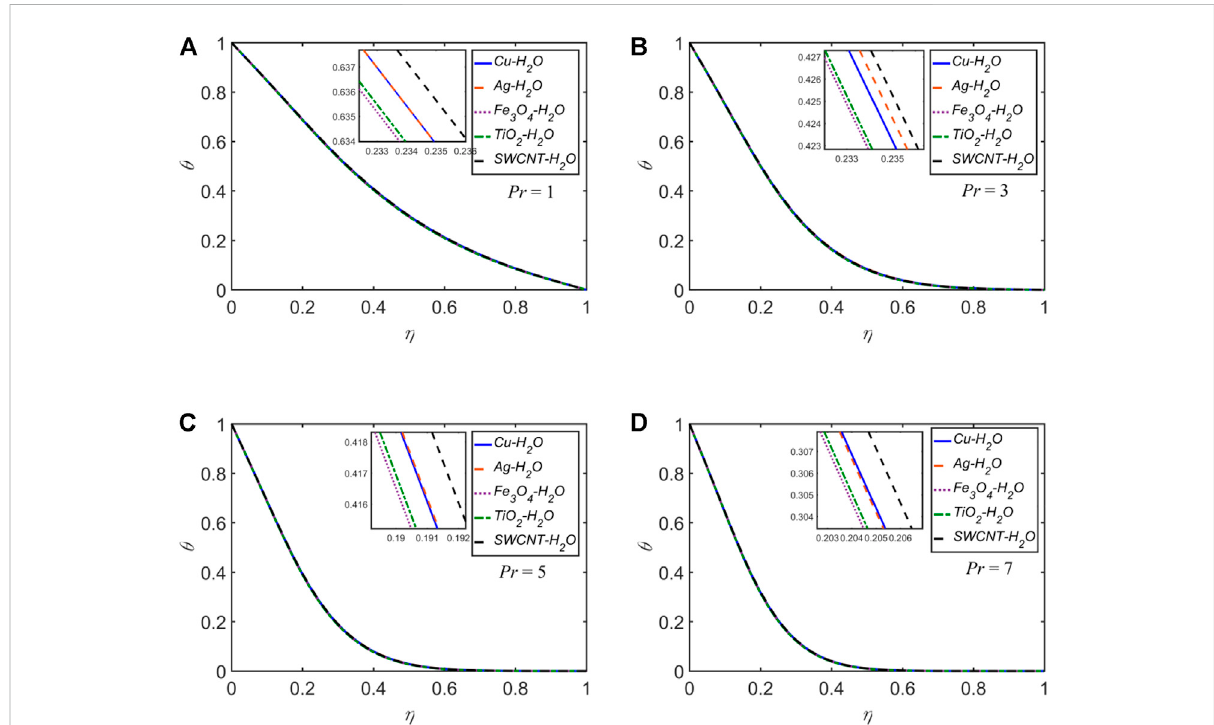
FIGURE 11 The temperature pro fi le θ versus η at x (cid:2) 0 and t (cid:2) 0 . 25 for the fi ve NFs for distinct values of Pr